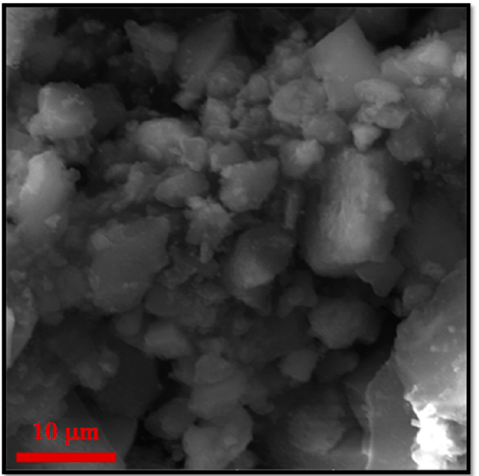
Figure 6. Additional, higher resolution SEM image for the sample ZF (Cl) MMOF .